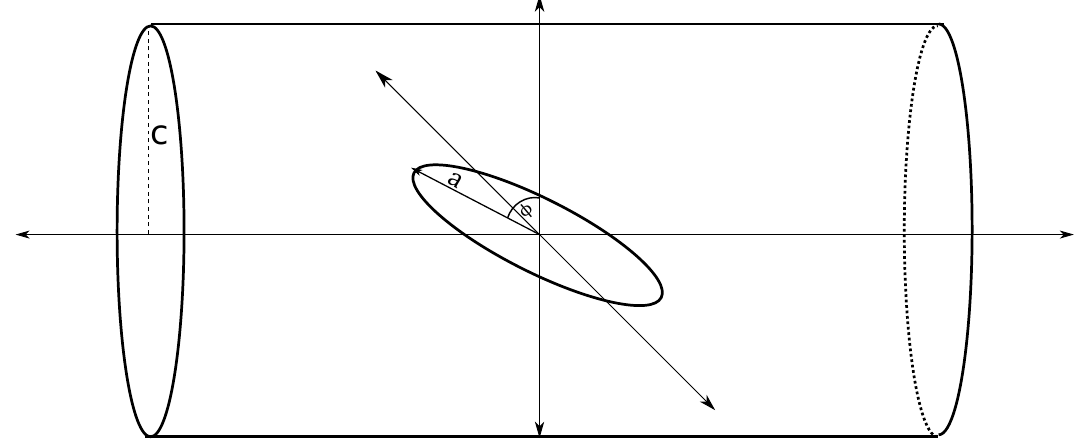
Figure 4. Circular ring lying within tube and centered on tube’s central axis and tilted by angle φ